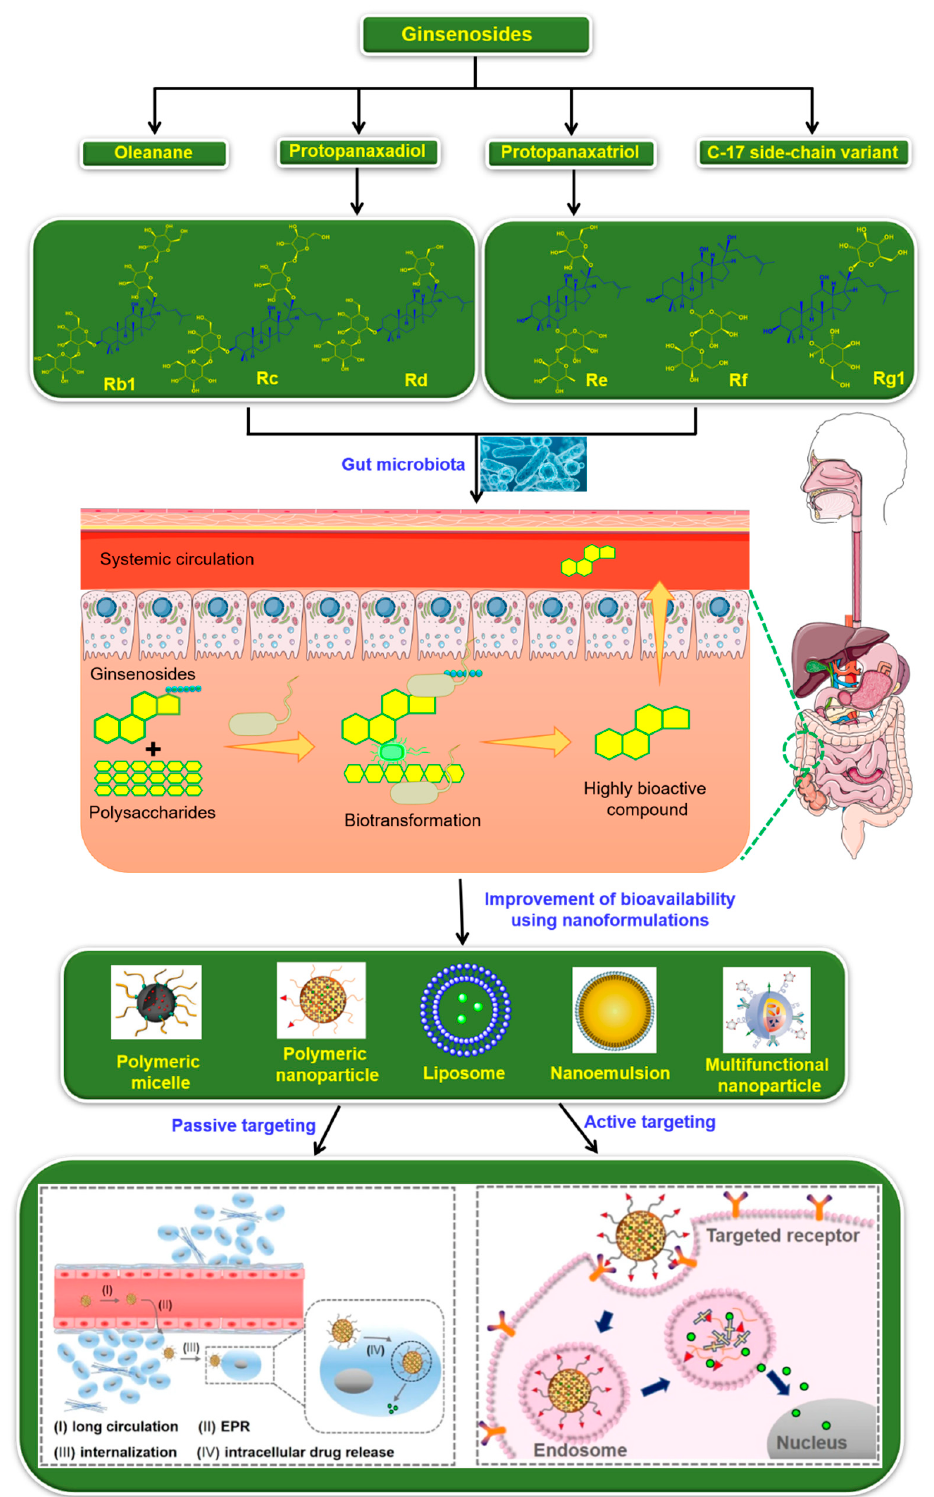
Figure 2. Schematic overview of classification of ginsenosides and their processing by gut microbiota. The gut microbiota effectively processes the ginsenosides into highly bioactive compounds which are then transfused through the systemic circulation. The bioavailability of ginsenosides is effectively improved by encapsulating into the nanoformulations and delivery of ginsenosides by passive or active targeting mechanisms.